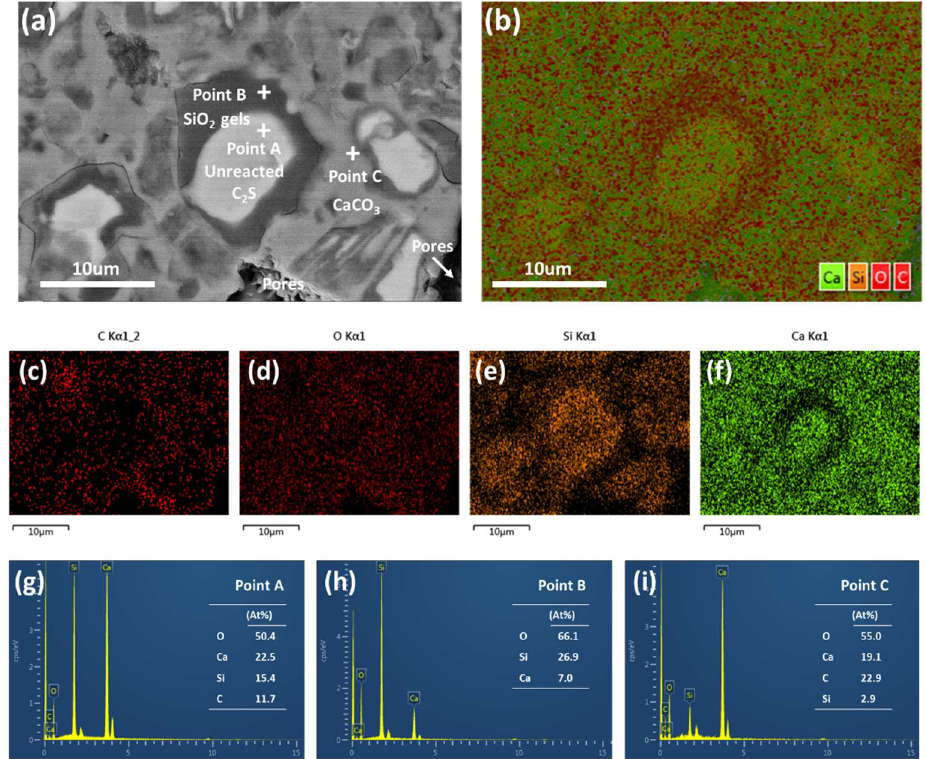
Figure 2. Backscattered electron (BSE) and energy-dispersive spectroscopy (EDS) images of β-C 2 S after carbonation. ( a ) BSE image; ( b ) elemental maps for composite element; ( c – f ) elemental maps for individual C, O, Si, and Ca, respectively; ( g – i ) EDS analysis of points A, B, and C.